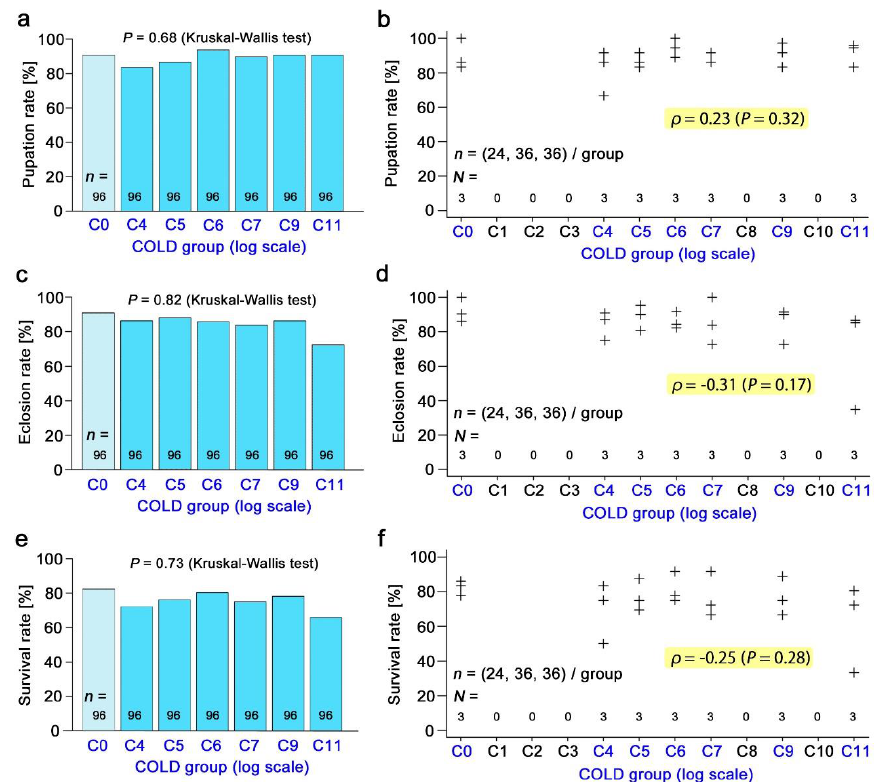
Figure 3. E ff ects of nonradioactive caesium chloride. In a, c, and e, all individual samples in the 3 trials were summed together, and the di ff erences among the groups were examined using a Kruskal–Wallis test. In b, d, and f, the three trials were independently plotted, and a Spearman correlation analysis was performed. N indicates the number of groups. ( a,b ) The pupation rate (%). ( c,d ) The eclosion rate (%). ( e,f ) The survival rate (%).